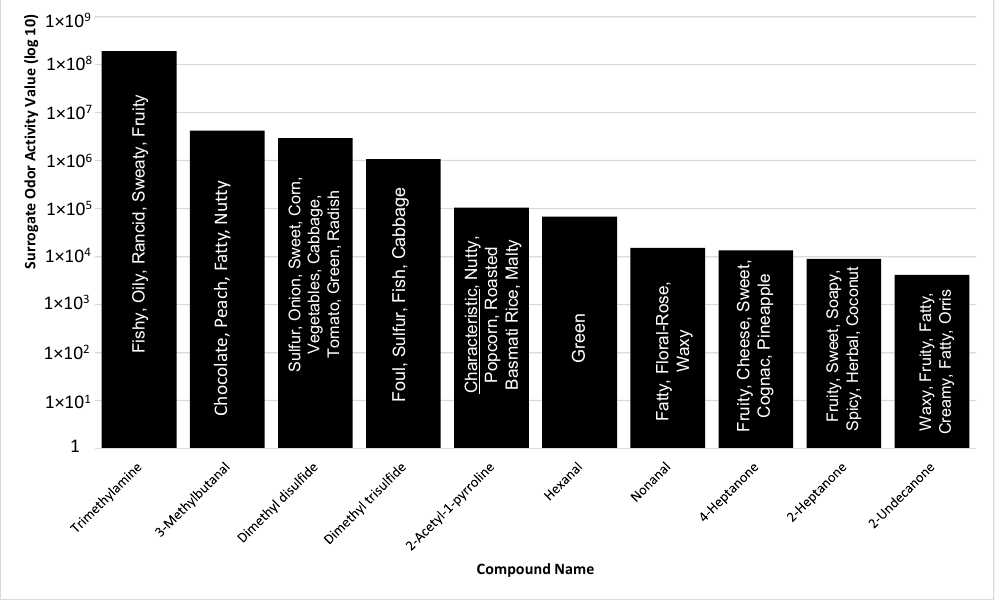
Figure 3. Summary of top 10 compounds, identified with standard chemical confirmation, in P. tigris altaica marking fluid with the highest surrogate odor activity values, SOAV (SOAV = odor detection threshold/peak area count) and their odor character descriptors. Confirmation of compounds was performed via chemical standards for all listed compounds with the exception of 2-AP.